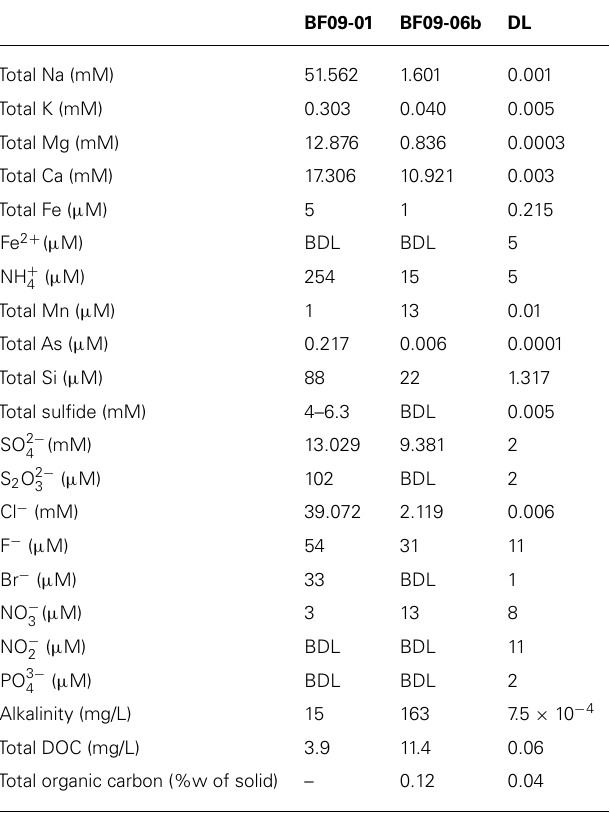
Table 3 | Geochemical analysis of the spring water (BF09-01) and water extracted from the glacial elemental sulfur deposit (BF09-06b) from which DNA was extracted and sequenced for the